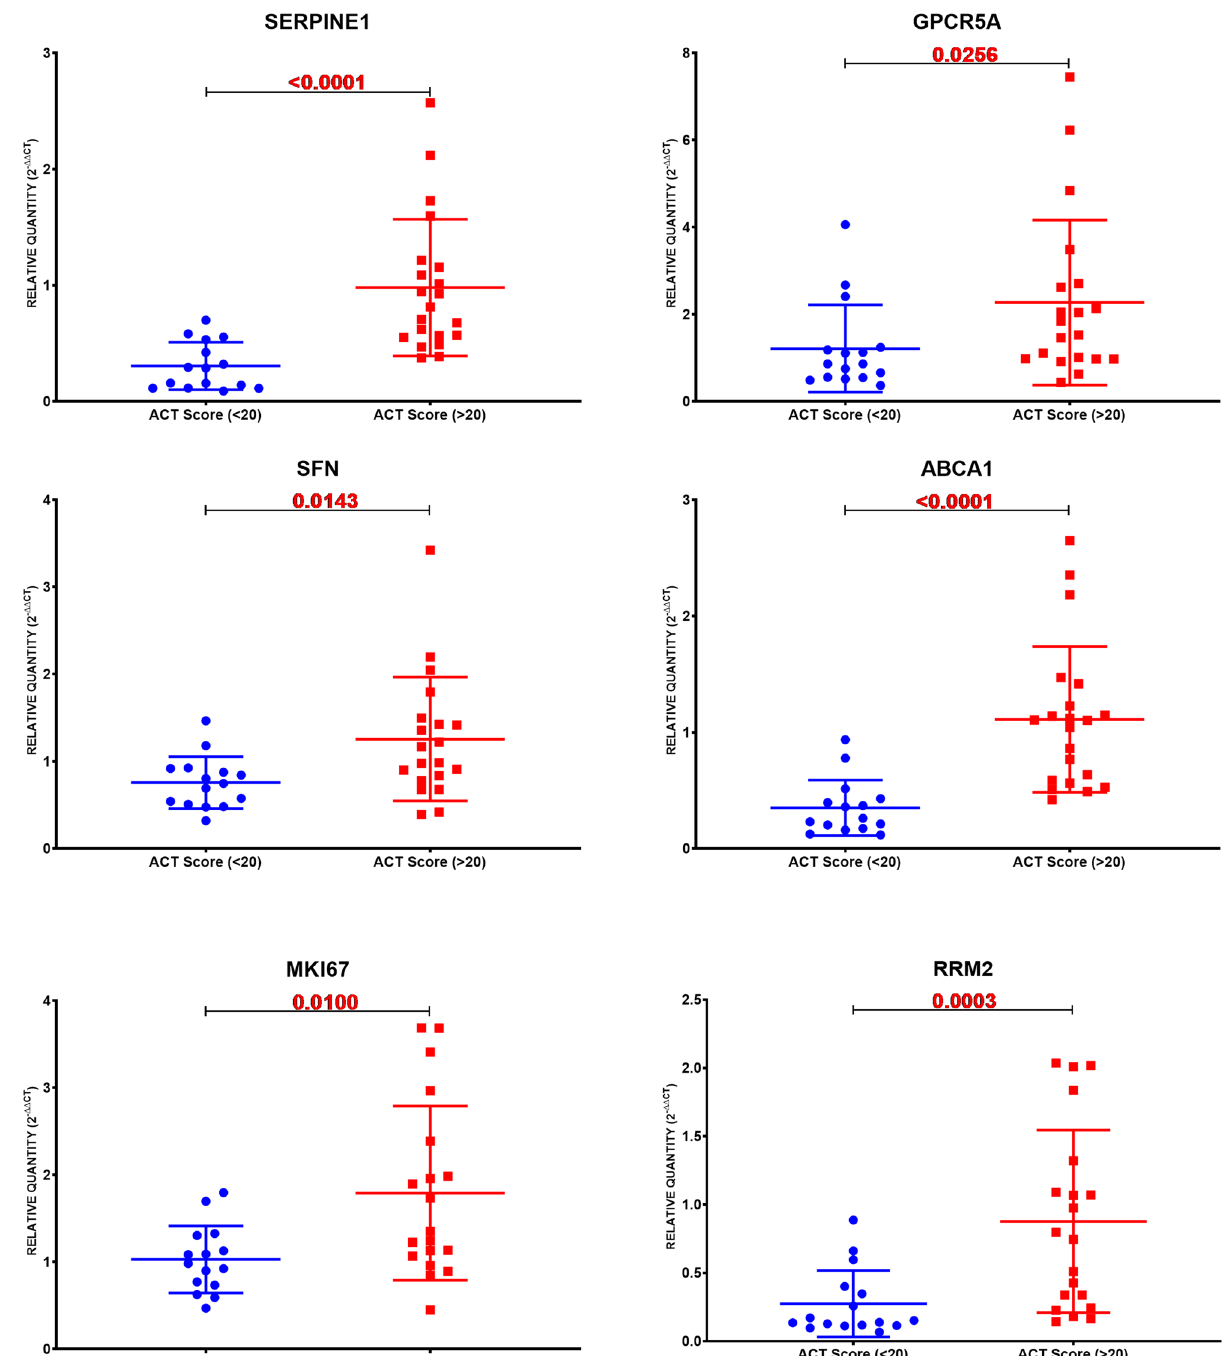
Figure 13. mRNA gene expression using RT qPCR of the ten genes in PBMC of a locally recruited cohort, the asthmatic patients were divided according to the ACT score into two groups: a well-controlled group (ACT > 20) and those with poor control (ACT <